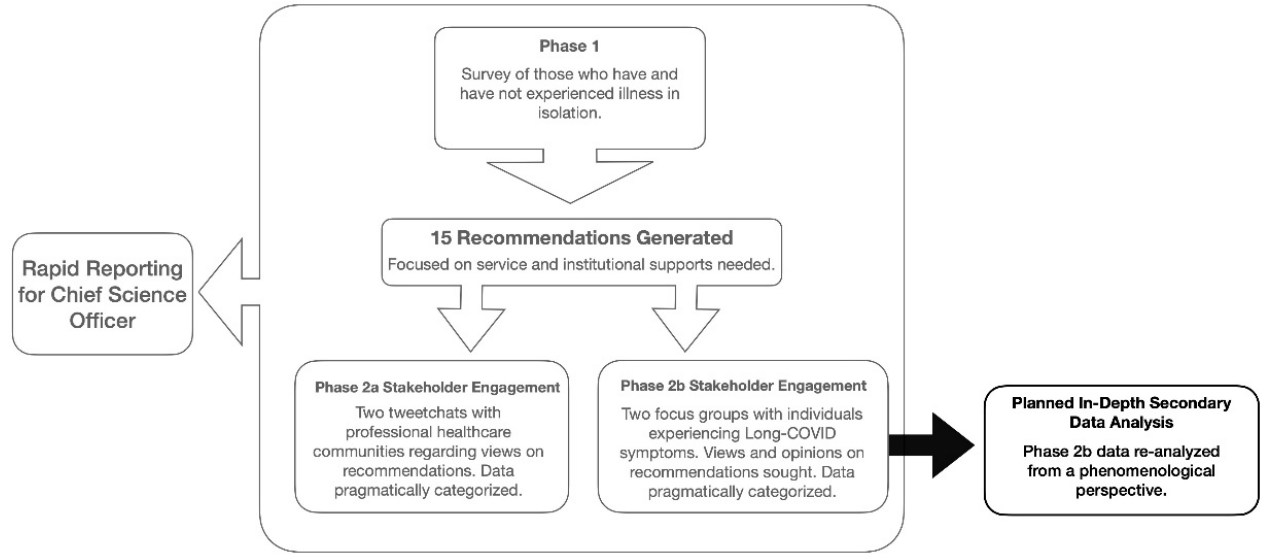
Figure 1. This image depicts the larger research project. This secondary qualitative data analysis is illustrated in bold.